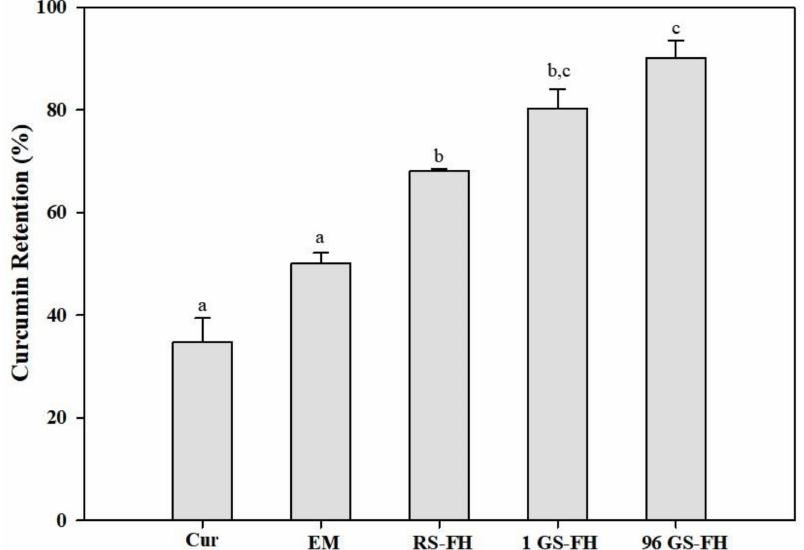
Figure 5. Retention rate (%) of curcumin (Cur), and curcumin-loaded in emulsion (EM), native rice starch-based filled hydrogel (RS-FH), 4- α -glucanotransferase treated (for 1 h) rice starch-based filled hydrogel (1 GS-FH), and 4- α -glucanotransferase treated (for 96 h) rice starch-based filled hydrogel (96 GS-FH) after in vitro digestion. The error bars represent the mean and standard deviations of triplicate experiments. Results marked with the different letter above the bars are significantly different ( p <